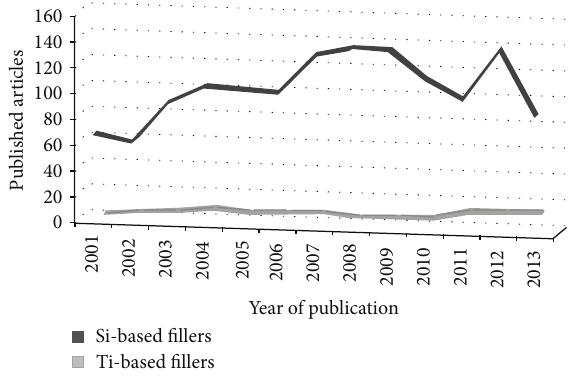
Figure 5: Popularity of Si-based fillers and limitation of Ti-based fillers usage in dental composites. (Search keywords: glass dental composite, Si dental composite, and Ti dental composite in ISI Web of knowledge until October